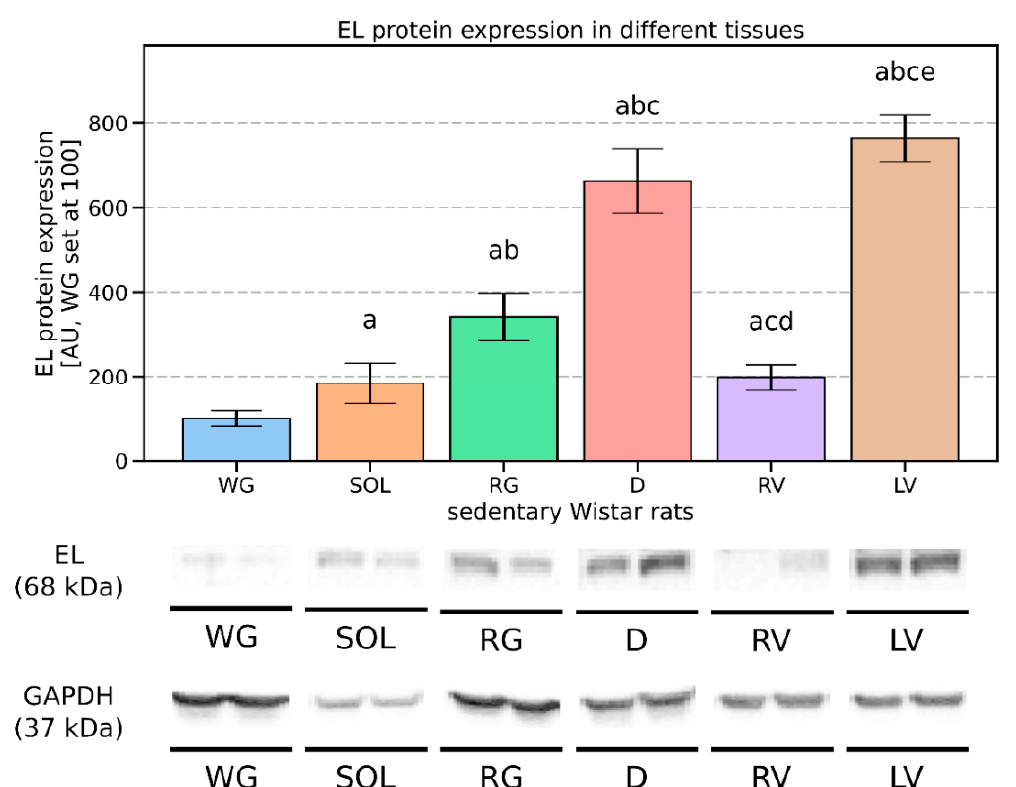
Figure 1. Endothelial lipase (EL) protein expression pattern in total muscle-tissue homogenates of sedentary control rats. Data are expressed as mean ± SD. For the sake of clarity, the EL expression level in the endothelium of white gastrocnemius muscle was set at 100 arbitrary units (AU), and the rest of the muscles are represented with respect to the WG. Representative Western blot images are shown. a—difference vs. white gastrocnemius muscle (WG), p < 0.05; b—difference vs. soleus (SOL), p < 0.05; c—difference vs. red gastrocnemius muscle (RG), p < 0.05; d—difference vs. diaphragm (D), p < 0.05; e—difference vs. right ventricle (RV), p < 0.05; n = 4 per group.